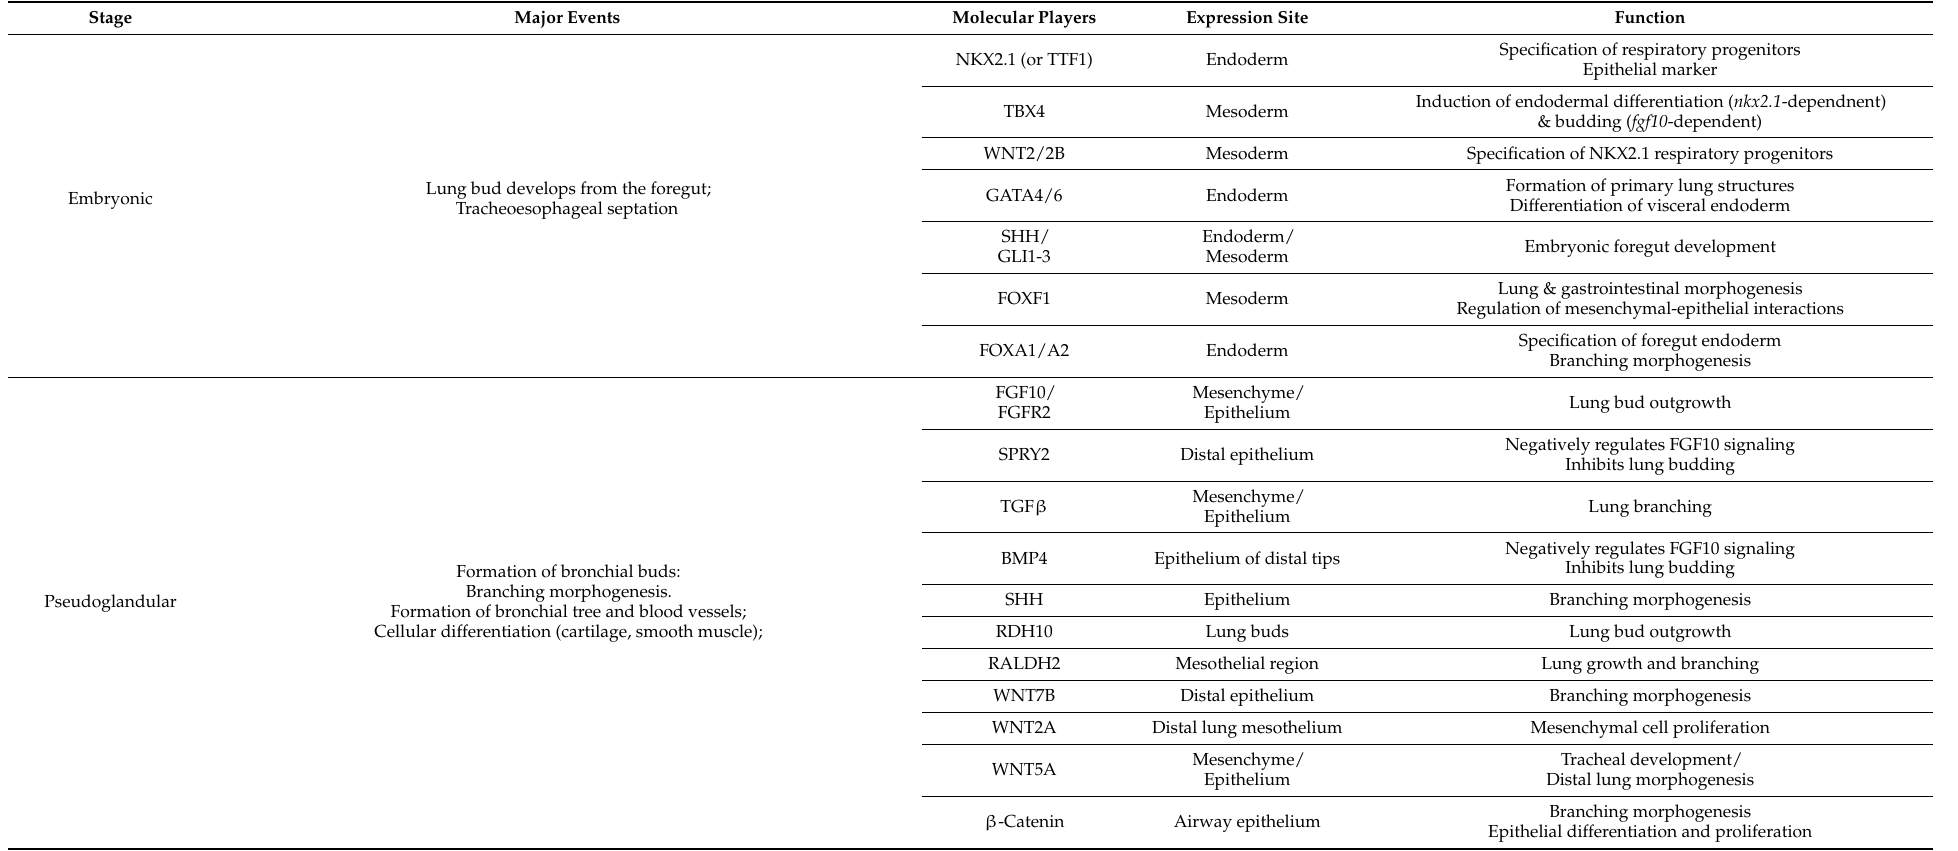
Table 1. Summary of the molecular players and corresponding major events underlying normal lung